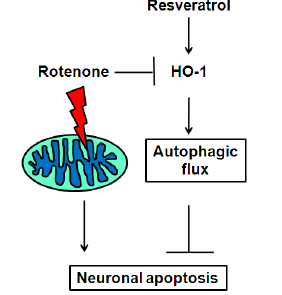
Figure 7. Schematic diagram of the role of HO-1 in mediating